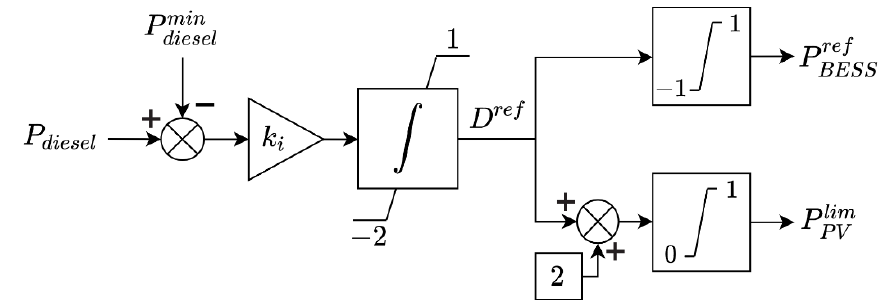
Figure 3. Priority EMS strategy.